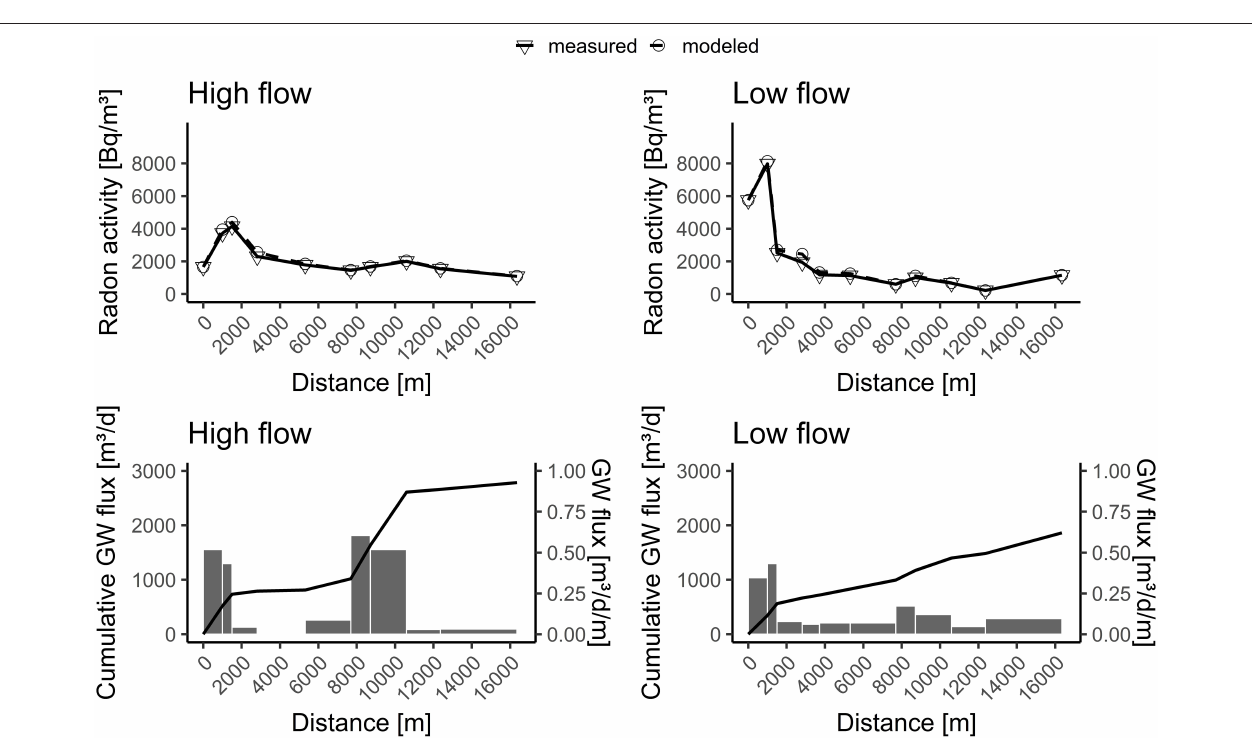
the whole stream length. In summary, our measurements of groundwater fluxes and their contribution to stream discharge indicate a positive correlation between groundwater